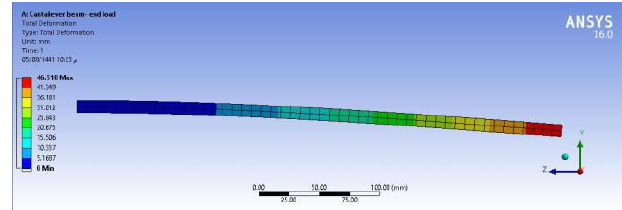
Fig. 6. Total deformation of the cemented carbide cantilever beam